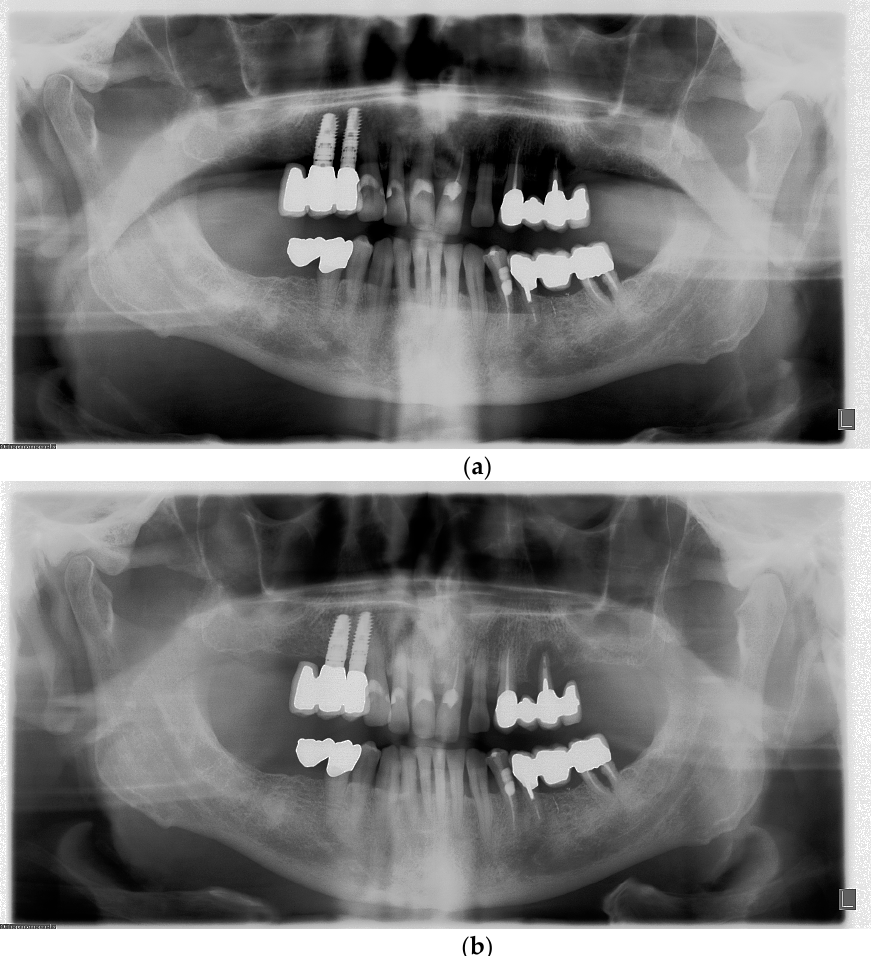
Figure 8. Position of the tongue: ( a ) tongue does not press against the palate. The shadow of the airspace causes a radiolucent area covering the upper teeth. ( b ) Tongue presses against the palate. The maxillary periapical bone tissues can be appropriately identified since the tongue acts as filter effect by absorbing X-rays in correspondence with the upper teeth roots. Note the radiopaque band overlapping the incisive area of both jaws.